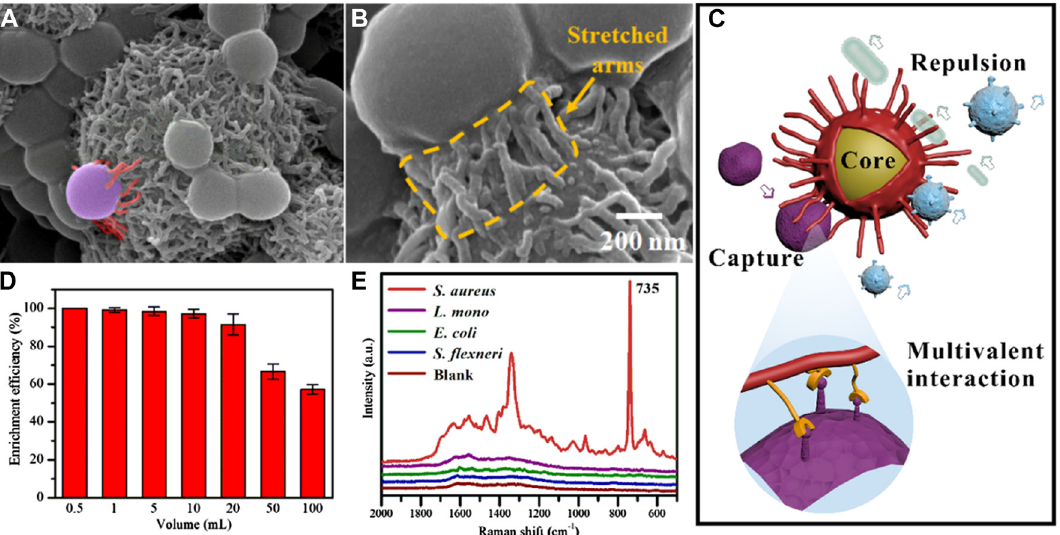
Figure 20: Scanning electron microscopy (SEM) images of (A) MAS-Ls- S. aureus and (B) the local enlarged images of the interaction between the arms and bacteria cell. Pseudocolored cell in image (a) shows the topographic interaction between the captured cell and MAS-Ls. (C) Schematicillustrationofthespeci fi ccaptureof S.aureus byMAS-Ls.(D)Enrichmentof102 S.aureus cellsby0.5mgMAS-Lsinvariedvolumes. (E) surface enhanced Raman scattering (SERS) detection of target bacteria after capture and separation: SERS spectrum of MAS-Ls binding with S. aureus , L. mono , E. coli , S. fl exneri , and blank samples, respectively, with bacteria concentration of 107 CFU mL − 1 . Reprinted with permission from [84], Copyright (2019) American Chemical